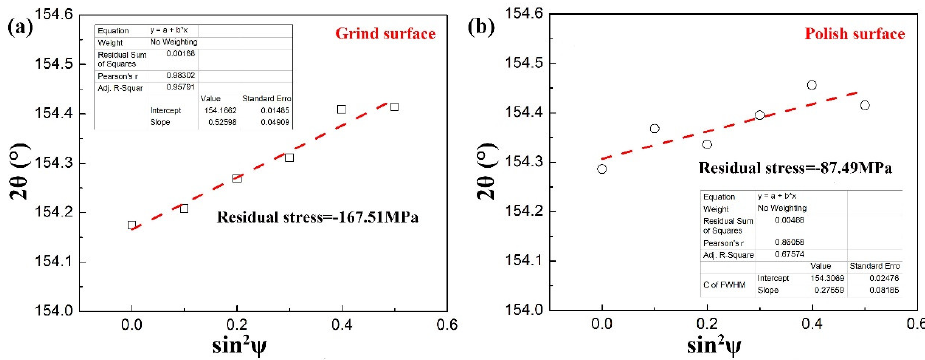
Figure 4. The 2θ vs. sin 2 ψ plot for the iron as determined by the sin 2 ψ method. ( a ) Grinded surface and ( b ) polished surface.